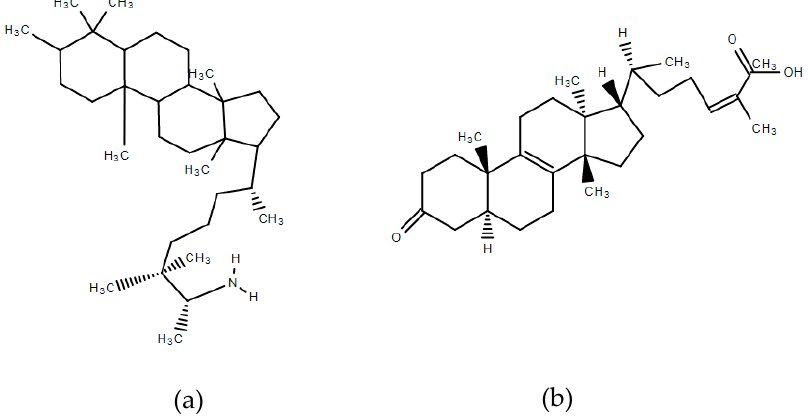
Figure 2. Major triterpenes of Mastiha. ( a ) Mastihadienonic acid; ( b ) Isomastihadienonic acid.